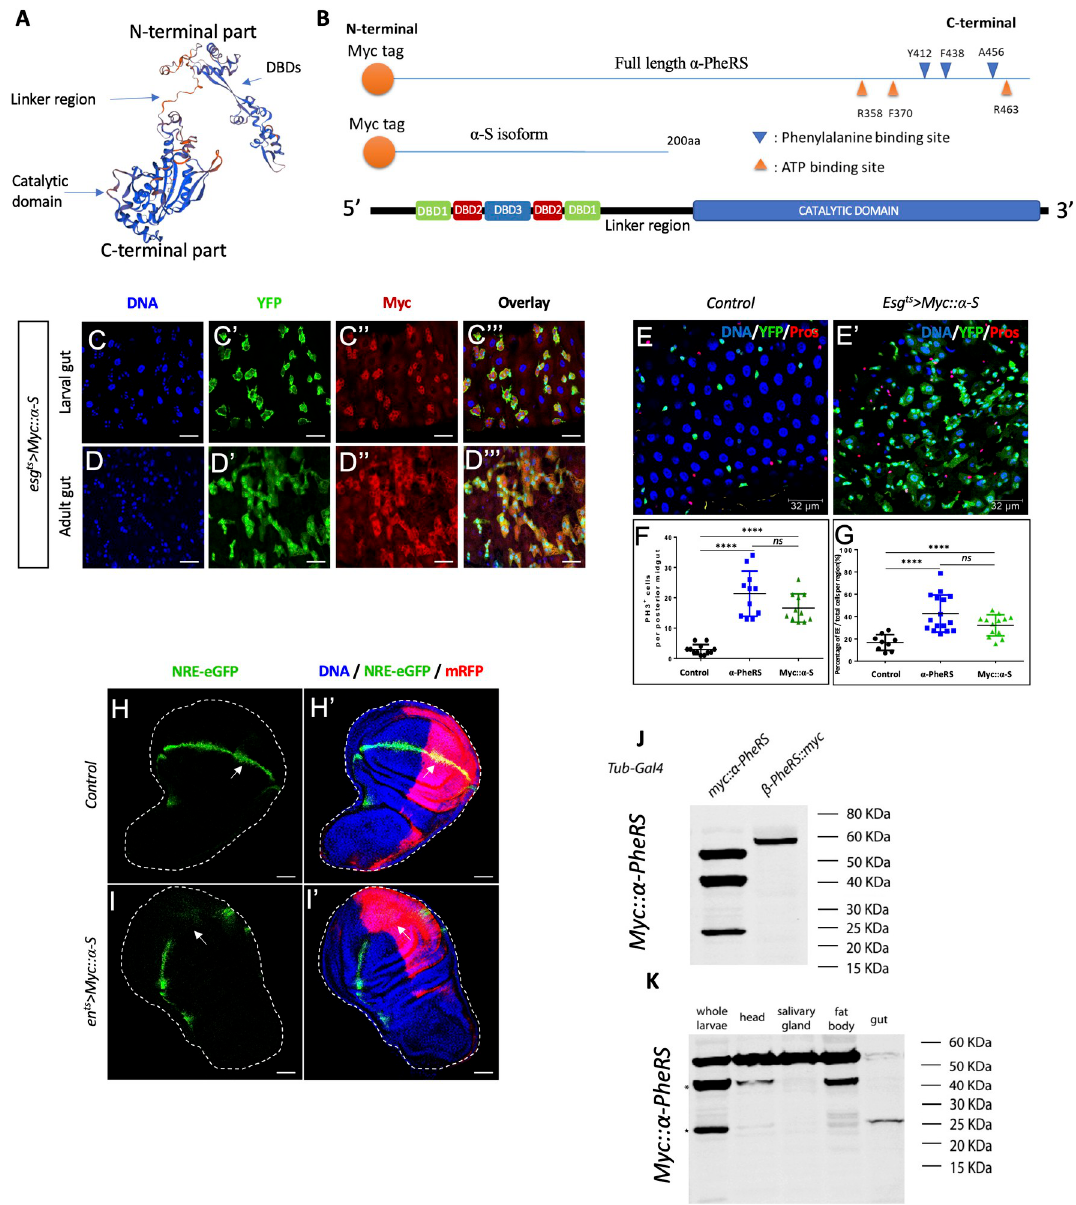
Fig 6. The N-term of α -PheRS ( α -S) is sufficient to induce the proliferative phenotype and repress Notch activity. (A) 3D model of the α -PheRS structure (suggested by SWISS MODEL tool https://swissmodel.expasy.org/) also shows that the catalytic module and the winged DBDs are separated from each other by a linker strand. (B) Schematic illustration of the α -PheRS polypeptide with its ATP and phenylalanine binding residues. α -PheRS has the catalytic domains located in the C-terminal part and the DNA binding domains (DBD-1,2,3) located in the N-terminal region. The Myc tagged α -S construct lacks all core domains of α -PheRS but encodes the first 200 codons of the α -PheRS ORF under UAS control. (C,D) Myc :: α -S was expressed using the esg ts system in adult and larval midguts and this led to similar phenotypes as elevated expression of α -PheRS (Cys) in the same system ( esg ts /UAS-Myc :: α -S) . (E-E’,F,G) Quantification of PH3 + cell numbers (F) and the proportion of EE per total cell number (G) in the intestinal region analyzed. In all experiments, EEs were visualized with the anti-Prospero antibody, YFP - /Hoechst + polyploid cells were counted as ECs. Animals were mated at 18˚C, and adults of the required genotypes were collected and shifted to 29˚C to inactivate Gal80 ts . Adult midguts were dissected from female flies after 5 days of induction at 29˚C. At least 10 guts were analyzed for each genotype. n = 10, �� p < 0.01, ��� p < 0.001, ���� p < 0.0001 in ANOVA tests. (H, I) Elevated Myc:: α -S leads to the loss of NRE-eGFP expression in the posterior compartments, similar to the effect of α -PheRS (Cys) . The same system and experimental setups were used as in Fig 5B–5E (w , UAS-Dcr2/+;en-Gal4 , UAS-mRFP , NRE-eGFP/+;tub-Gal80 ts /UAS-Myc :: α -S) . (J, K) Besides the full-length α -PheRS isoform (55kDa), one stable Myc-tag containing isoform around 40 KDa and another around 25KDa appear when expressing transgenic Myc:: α